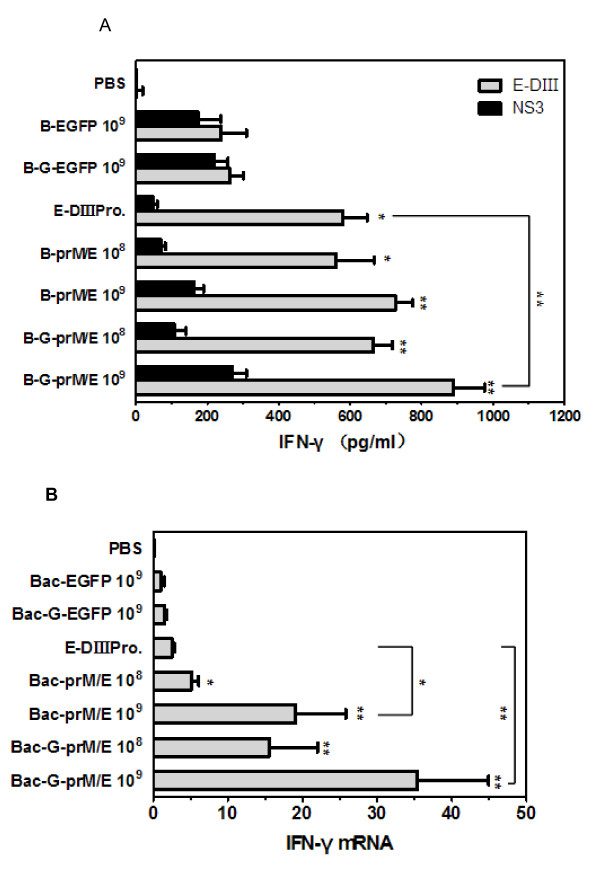
IFN-γ responses induced by immunization with recombinant baculoviruses.(A) Production of IFN-γ in the supernatant of splenocytes harvested from immunized mice after in vitro restimulation was determined by ELISA. Splenocytes of immunized mice were isolated 6 weeks after the primary immunization and incubated in vitro with E-DIII protein or NS3 protein for 72h. Data represent the mean concentrations of IFN-γ in the supernatant ± SD of the three independent experiments. (B) IFN-γ relative gene expression in splenocytes harvested from immunized mice after in vitro restimulation with or without E-DIII protein for 24h. RNA was extracted and subjected to RT-PCR. Relative quantity of IFN-γ mRNA expression was determined by relative quantitative real-time PCR using β-actin gene as housekeeping gene. The bars in graph denote the mean relative quantity of IFN-γ mRNA ± SD observed from three mice per group, each performed in triplicate. *, p<0.05; **, p<0.01 compared to the value for 109 PFU of Bac-G-EGFP (control virus)-immunized group.